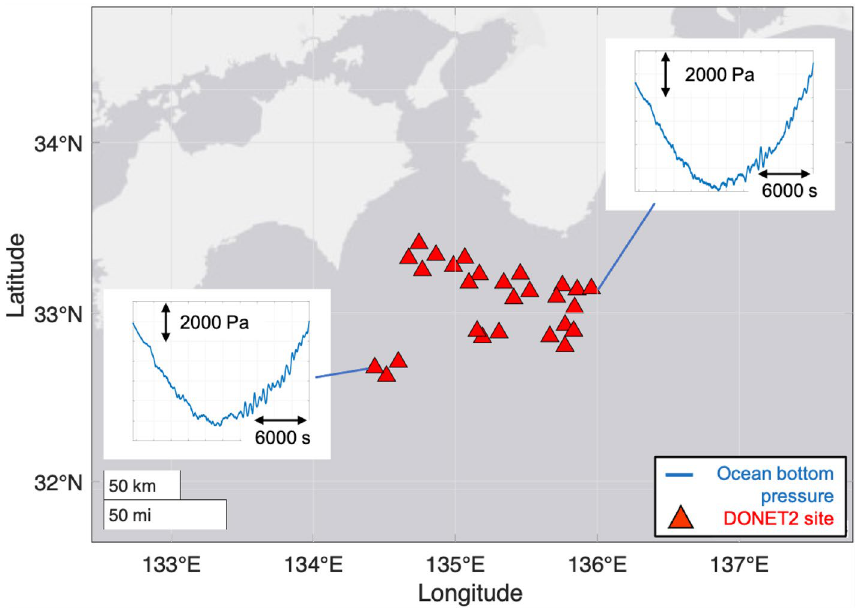
Figure 2. Location of DONET2 (Dense Oceanfloor Network system for Earthquakes and Tsunamis) sites. These 27 ocean bottom pressure gauges are installed for the early detection of tsunamis by observing the vertical movement of the sea surface through the observation of changes in water pressure. The map is created with Matlab R2022B (www. mathw orks.